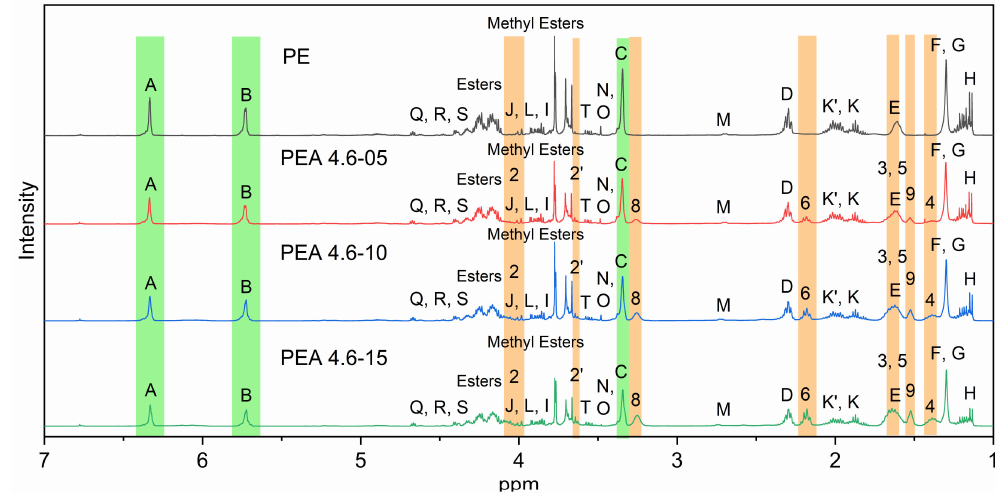
Figure 2. 1 H NMR spectra of the neat polyester resin and PEAs containing di ff erent amounts of amido diol 4.6.